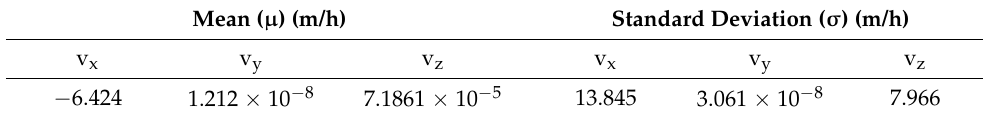
Table 5. Average (mean) value and standard deviation of the velocity